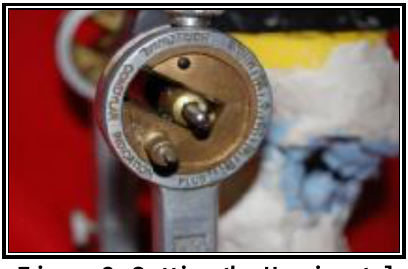
Figure 3: Setting the Horizontal Condylar Angle.